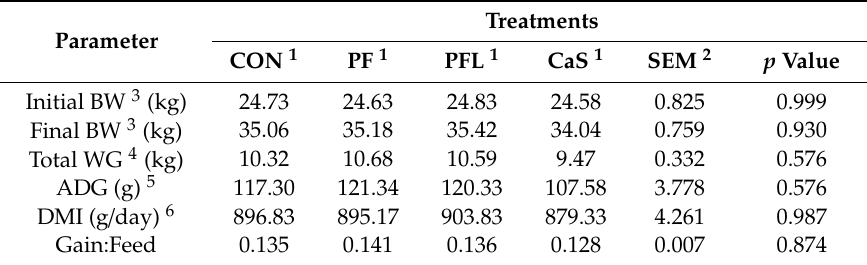
Table 4. E ff ect of rumen protected fat on body weight changes, average daily gain and gain:feed ratio in Dorper